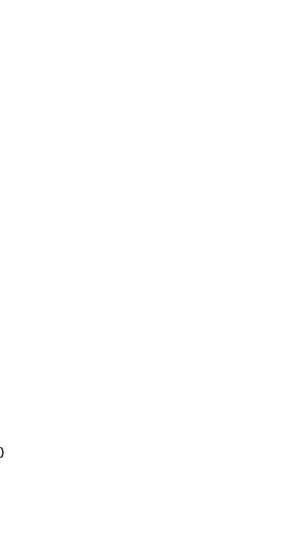
Fig 10. PA and loss curves of two segmentation models. a) U-Net; and b) Mask R-CNN.